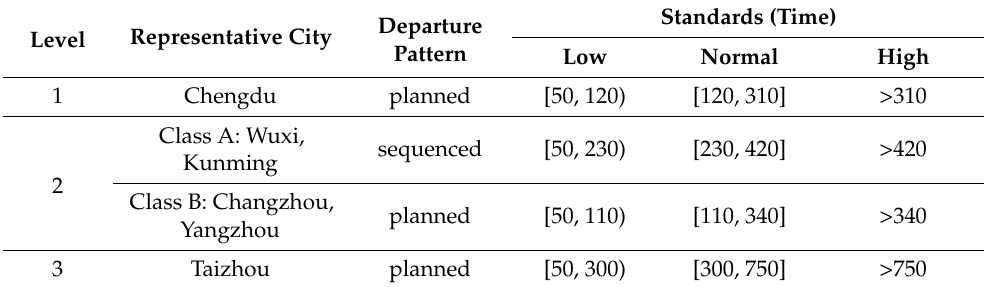
Table 12. Standards of dispatched frequency per capita.